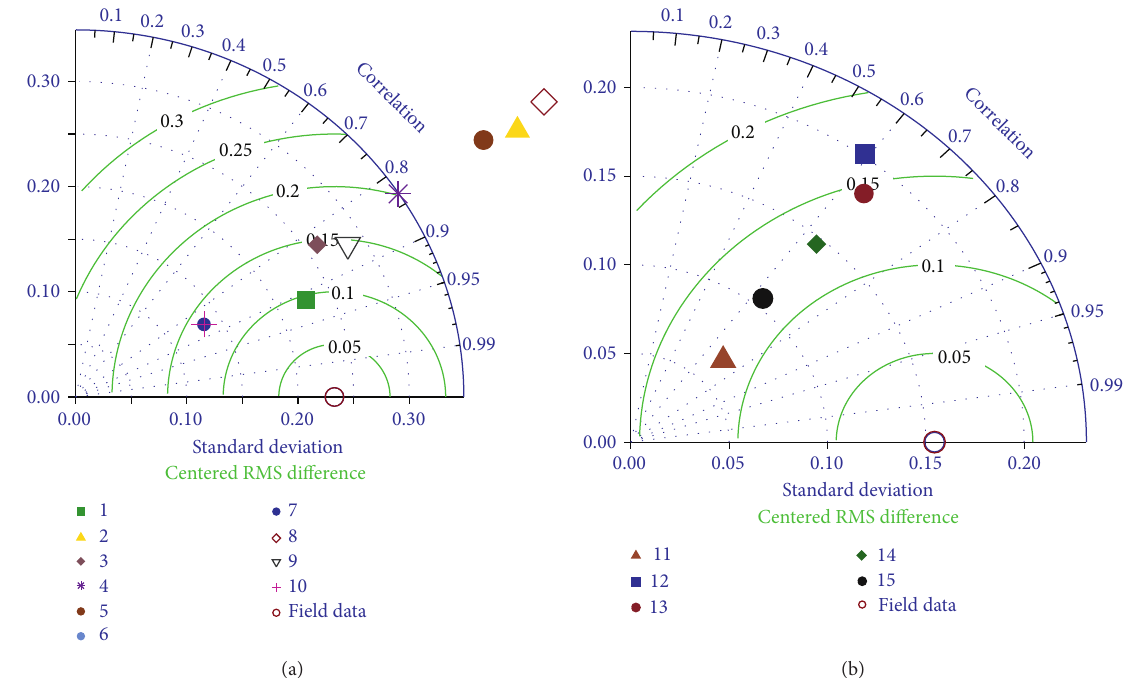
Figure 7: Taylor diagrams (a) deceleration rate models and (b) acceleration rate models. Table 13: Summary of the models and statistics. Model